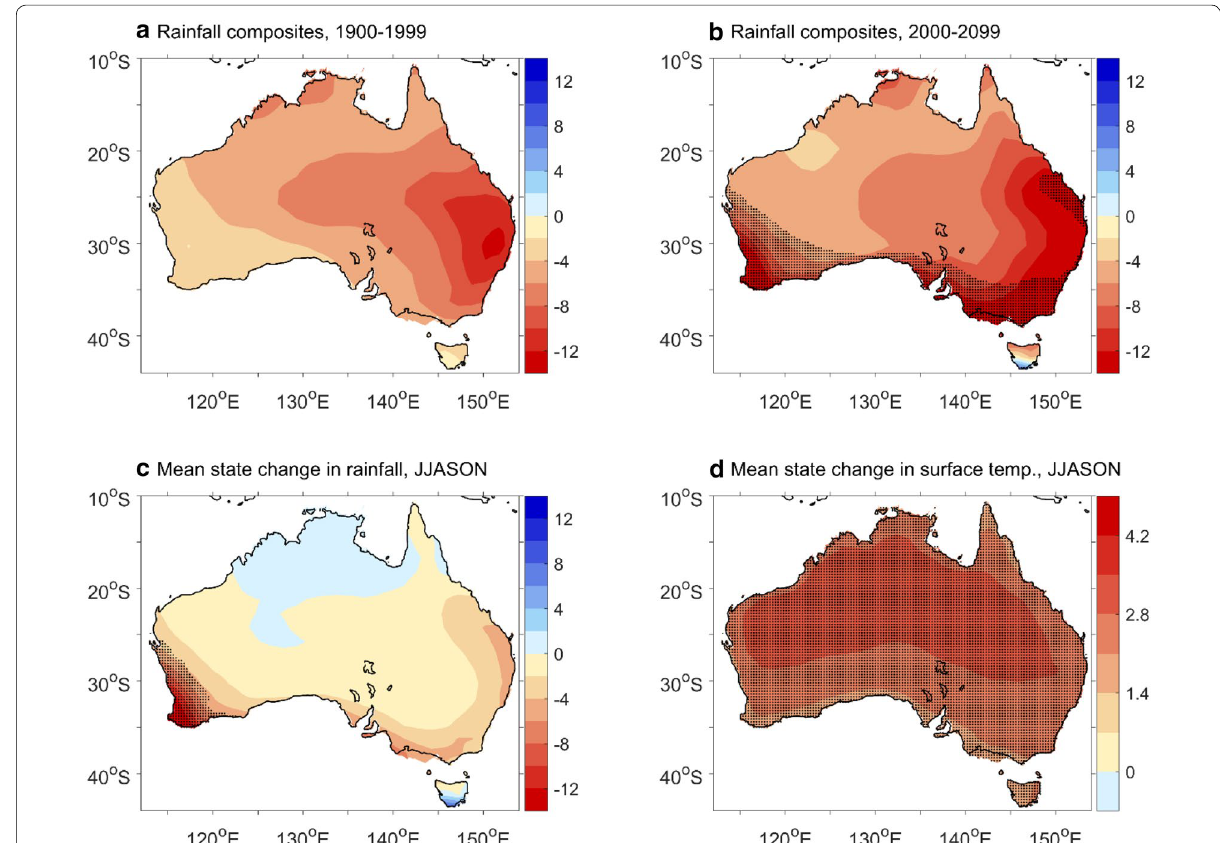
Fig. 5 Possible influences from mean state change under greenhouse warming based on CMIP6. a Composites of JJASON mean rainfall anomalies (mm per month) for events that are similar to 2018–2019 sequences in the Control climate, i.e., 1900–1999. b The same as a , but for the Future climate, i.e., 2000–2099. Dotted areas indicate where the difference between a and b is significant at the 95% confidence level based on a Student t -test. c Projected changes in Australia JJASON rainfall between 2000–2099 and 1900–1999. d The same as c , but in surface temperature (°C). Results are based on 23 CMIP6 models that produce reasonable ENSO diversity (Cai et al. 2018). Dotted area in c and d indicate where the difference between two period is significant above the 95% confidence level based on a Student t